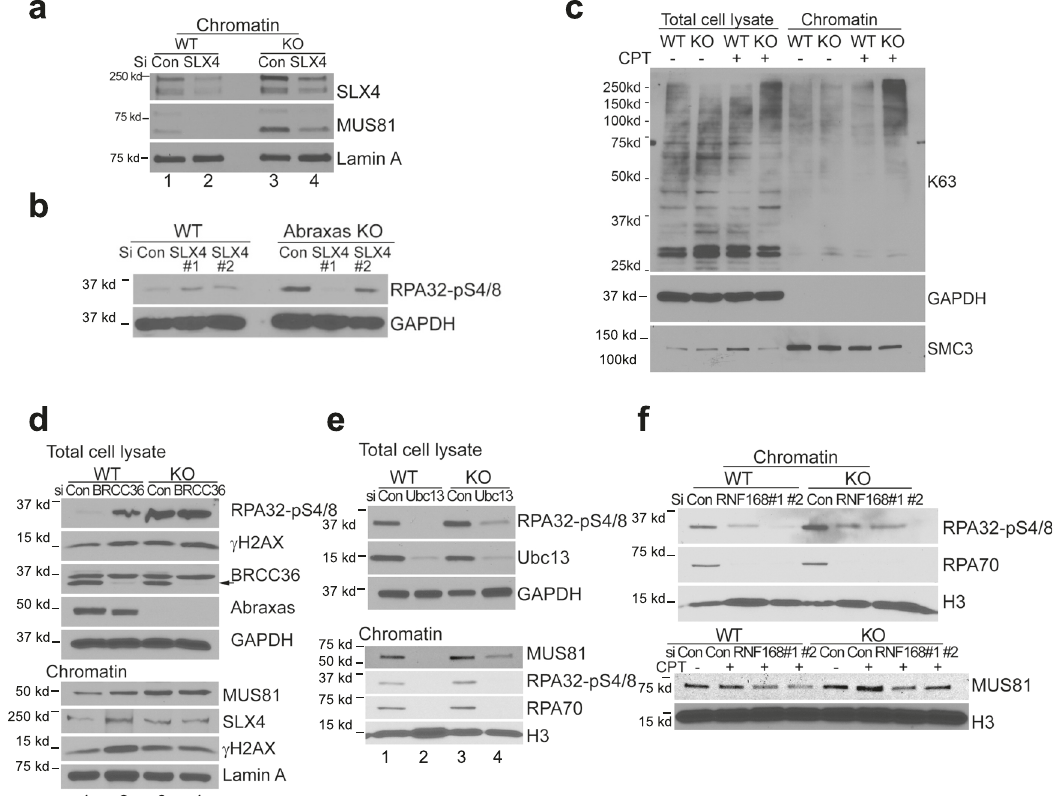
Fig. 5 Abraxas limits K63-linked ubiquitin-dependent SLX4/MUS81 recruitment to CPT damage sites. a Increased chromatin-bound MUS81 in Abraxas KO cells was reduced by SLX4 knockdown. Cells transfected with indicated siRNAs were treated with 1 μ M CPT for 1 h. Chromatin fraction was isolated for analysis by western blottings. b SLX4 knockdown reduced the elevated RPA32-pS4/8 levels in Abraxas KO treated with CPT. Total lysates were used for western blottings. c K63-linked polyubiquitination is increased in Abraxas KO U2OS cells treated with CPT. WT and Abraxas KO U2OS cells were untreated or treated with 1 μ M CPT for 1 h. Total cell lysates and chromatin fractions were prepared from samples for western blottings. K63-linked ubiquitination was detected by antibodies against K63-linked chain. d BRCC36 knockdown leads to increased RPA32-pS4/8 and overloading of SLX4/MUS81 to CPT- damaged chromatin. Total cell lysates and chromatin fractions were prepared from cells transfected with indicated siRNAs and treated with CPT (1 μ M, 1 h). e Ubc13 knockdown reduced elevated RPA32-pS4/8 levels and chromatin-bound MUS81 in Abraxas KO cells treated with CPT. f RNF168